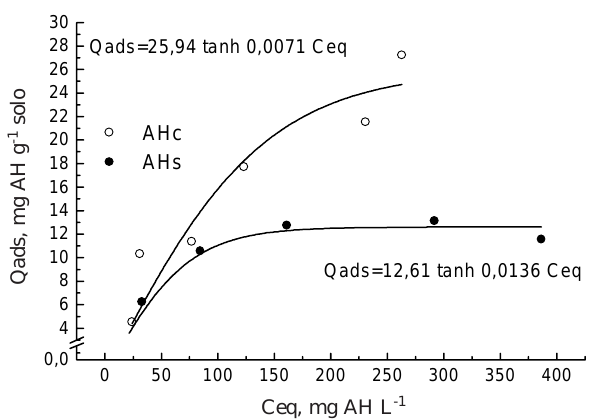
Figura 1. Isotermas de adsorção de ácidos húmicos extraídos de solo (AHs) e de carvão (AHc) em Latossolo Roxo natural. Ceq = concentração de AH em equilíbrio e Qads = AH adsorvido. Os coeficientes de determinação das equações são apresentados no quadro